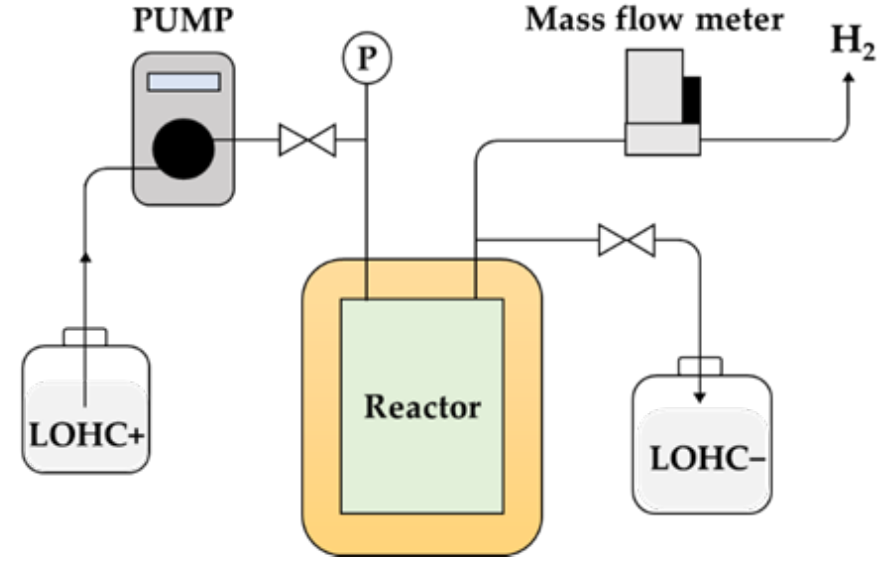
Figure 3. Schematic diagram of the dehydrogenation catalyst test bed ( left ) and two identical PFR reactor apparatus setup for investigating the dehydrogenation kinetics of H18-DBT ( right ). Implementation of the schematics designed for the PFR reactor shown in Figure 3 was carried out and two identical PFR reactor apparatuses were set up, as shown in Figure 4. H18-DBT was initially stored in the glass container and was pre-heated to 70 ◦ C via temperature-controlled magnetic stirrer and heater. After the reactor reached the thermal equilibrium, H18-DBT was injected into the heating section of the reactor via HPLC pump (FLOM, Tokyo, Japan, Dual pump KP-22) where the reaction temperature was achieved before contacting the catalyst. The reactor was located within the housing of the temperature-controlled electric furnace maintained at the desired reaction